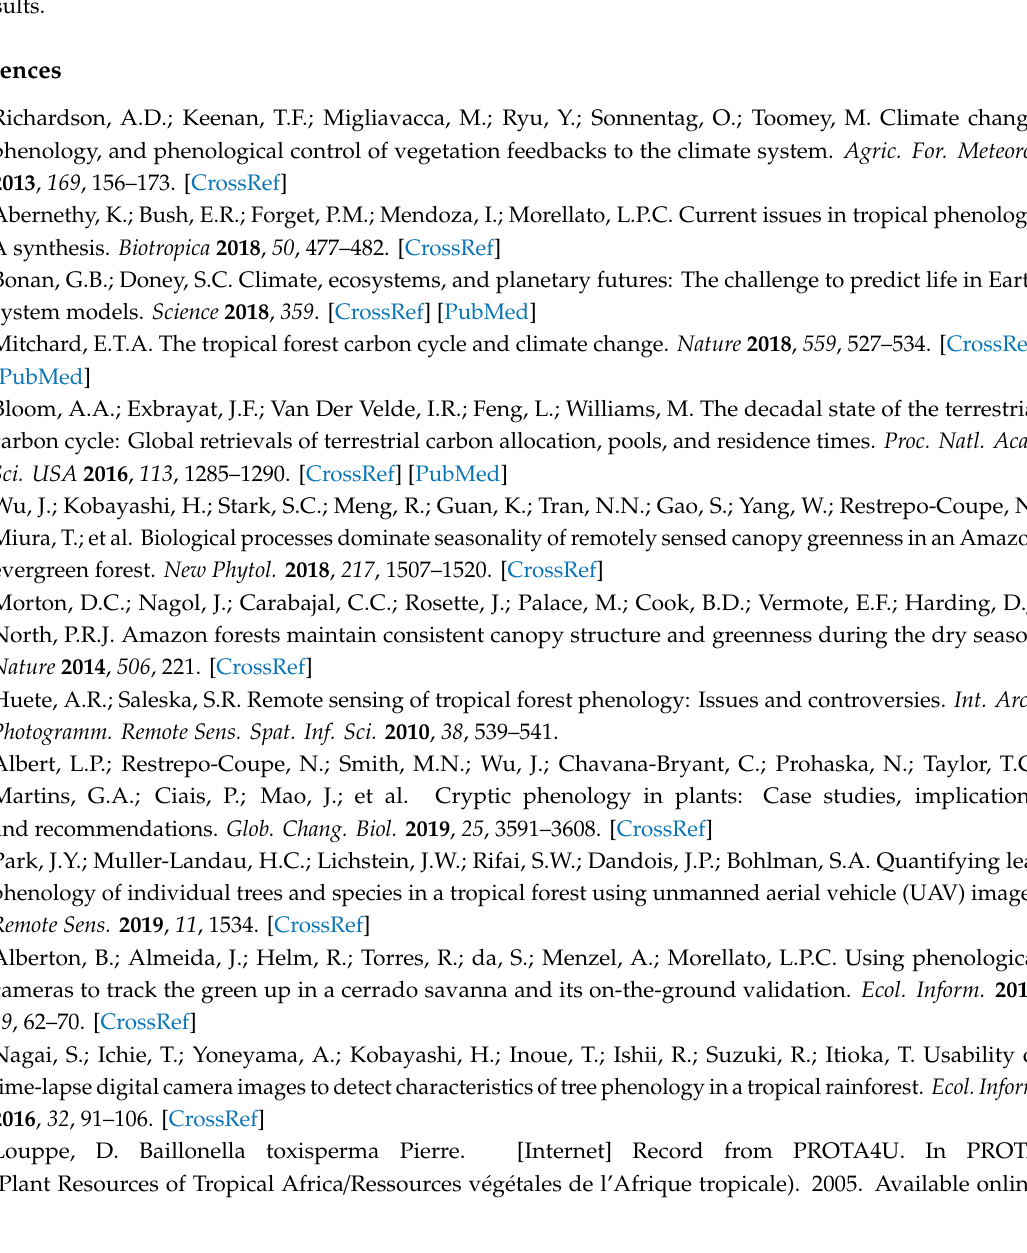
Figure S1: Focal crown time series for Sentinel-1 VV band, Figure S2: Focal crown time series for Sentinel-1 VH band, Figure S3: Focal crown time series for Sentinel-2 NDVI, Figure S4: Focal crown time series for Sentinel-2 GLI, Figure S5: Boxplots of canopy and normalized canopy data for all satellite data, Table S1: Model estimates for extended leaf renewal